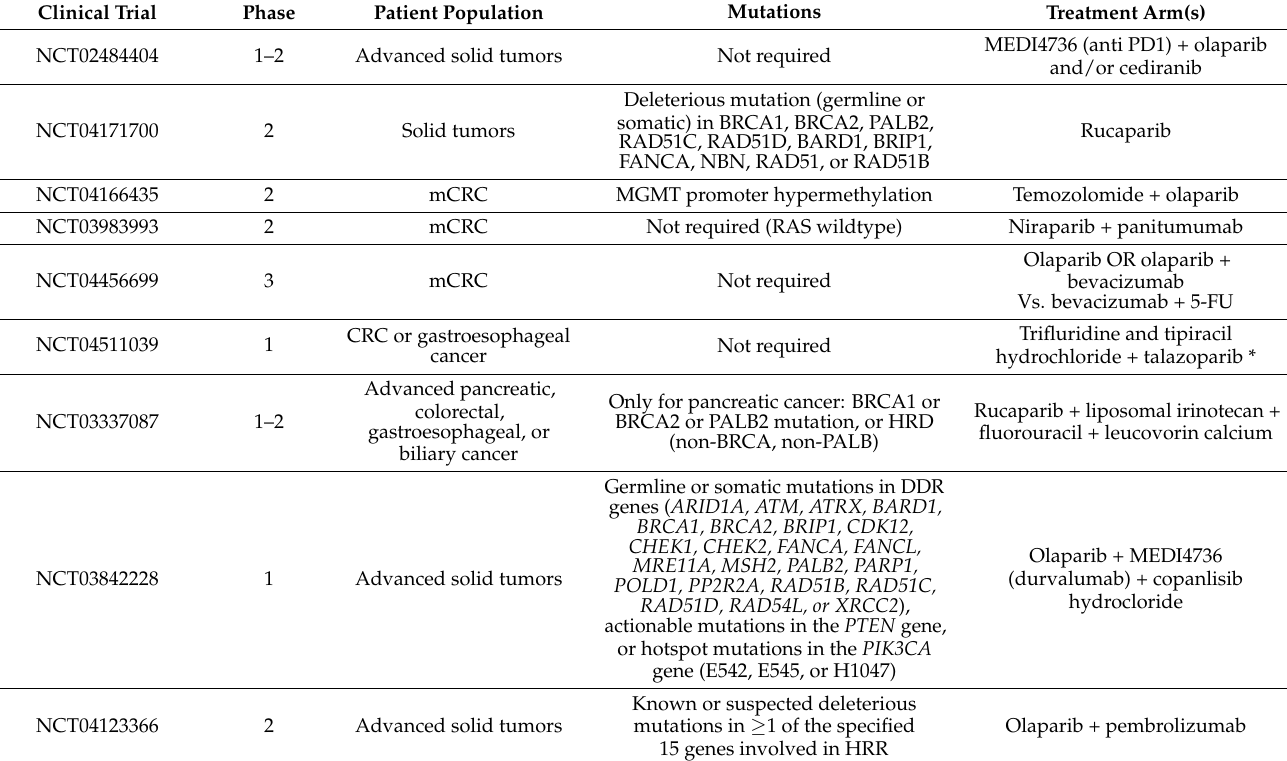
Table 2. Active clinical trials on PARPi in